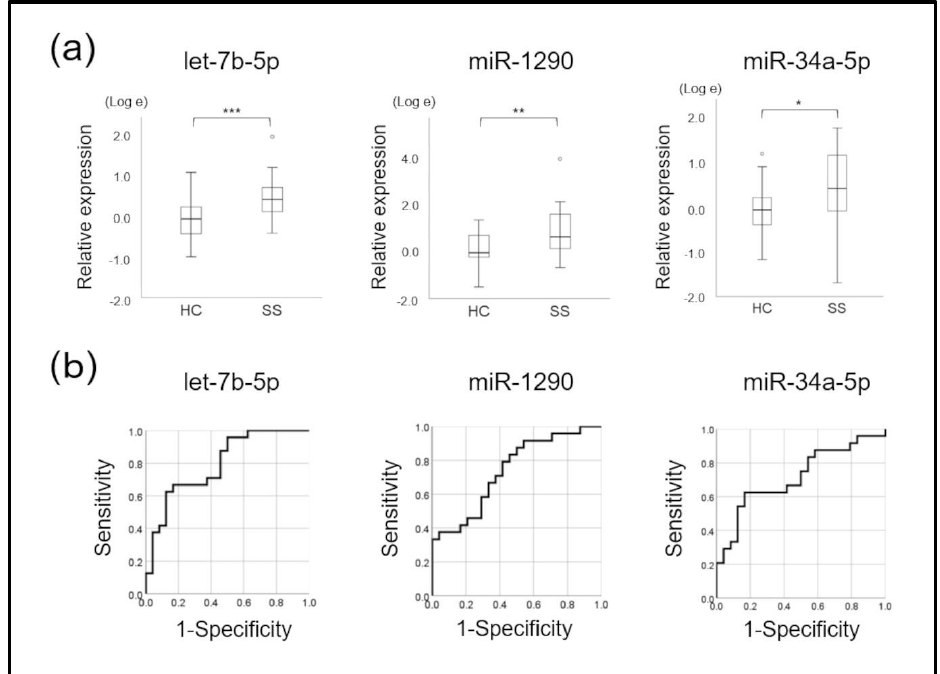
Figure 3. Three microRNAs with significant differences. ( a ) Comparison of normalized signal intensity of three microRNAs (miRNAs) between patients with Sjögren syndrome (SS) and controls (HC). There were significant differences in signal intensity between miRNAs let-7b-5p, miR-1290, and miR-34a-5p ( p < 0.05, t -tests). * p < 0.05, ** p < 0.01, *** p < 0.001. ( b ) The areas under ROC curves (AUCs) were higher for the miRNAs let-7b-5p, miR-1290, and miR-34a-5p than the other six miRNAs, which could not significantly discriminate Sjögren syndrome (SS) from controls. * p < 0.05, ** p < 0.01, *** p < 0.001.